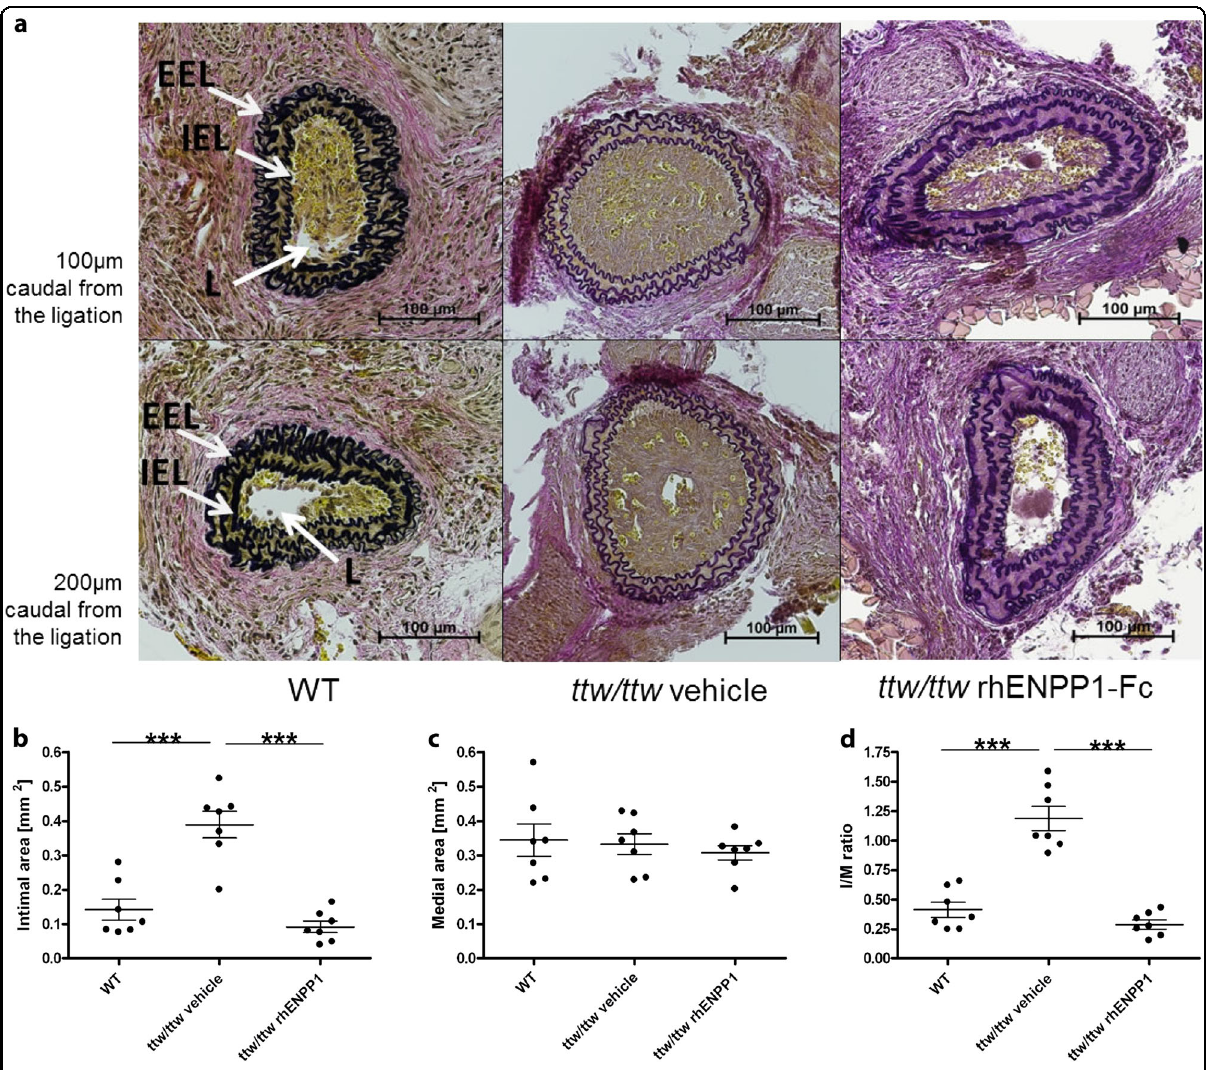
Fig. 4 Administration of rhENPP1-Fc prevents intimal proliferation after carotid ligation in ttw/ttw mice. RhENPP1-Fc treatment was started 7 days prior to carotid ligation, and serial sections of the left carotid arteries were taken 14 days after carotid ligation. Histological analysis (Von Gieson ’ s stain) was performed on sections taken either 100 (upper panel) or 200 (lower panel) µm from the point of ligation from WT, vehicle-treated ttw/ttw or rhENPP1-treated ttw/ttw - mice, shown from left to right ( a ). The internal elastic lamina (IEL), external elastic lamina (EEL), and lumen (L) are indicated by arrows. The scale bar represents 100 µm. Morphometric quantitation was performed on intimal ( b ) and medial ( c ) areas, and the I / M ratio was calculated ( d ). Values are presented as the mean ± SEM, n = 7 each group, *** p < 0.001 (one-way ANOVA multiple group comparison followed by the Bonferroni ’ s post hoc